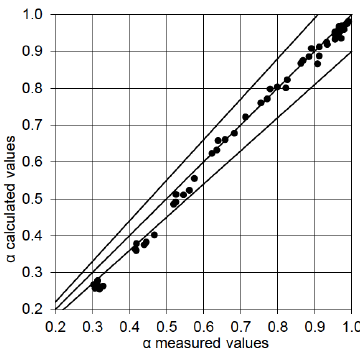
Figure 14: Measured and calculated normalincidence sound absorp- tion coeflcient comparison (2 mm air gap)